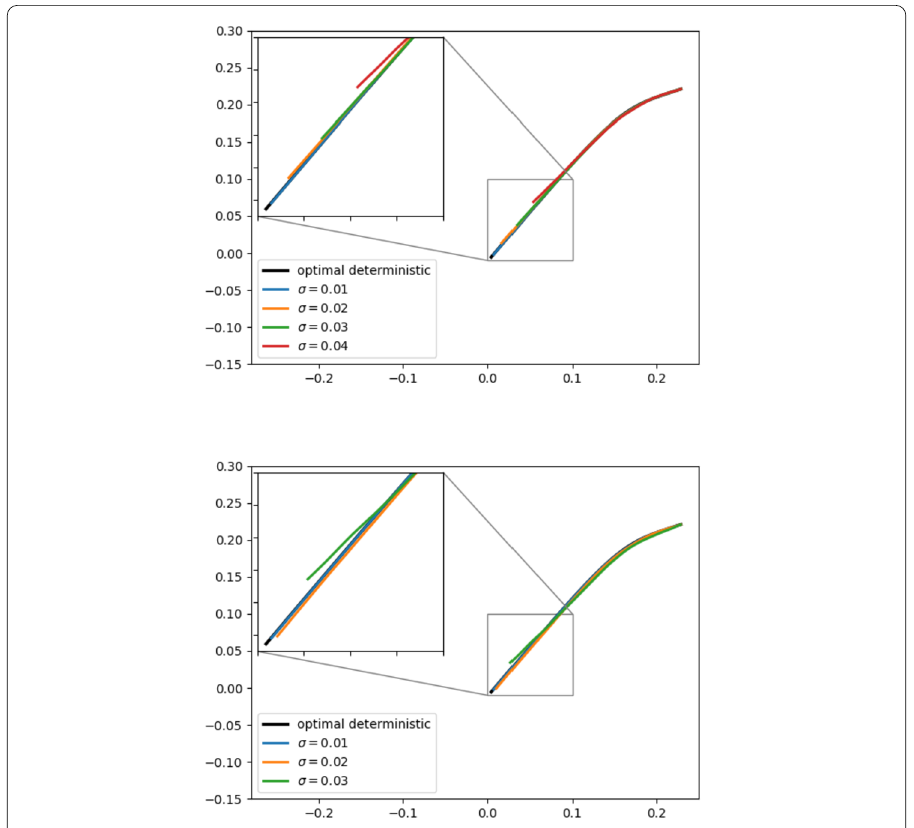
Figure 2 Up: We show the trajectories for the centre of mass of the crowd employing the optimal deterministic controls. The accuracy of the deterministic controls deteriorates as the stochastic influence increases. For σ = 0.03 the stochastic influence starts to superimpose the crowd behaviour. Down: The trajectories of the centre of mass of the crowd resuting from the space mapping procedure. We see that the trajectory corresponding to σ = 0.02 was